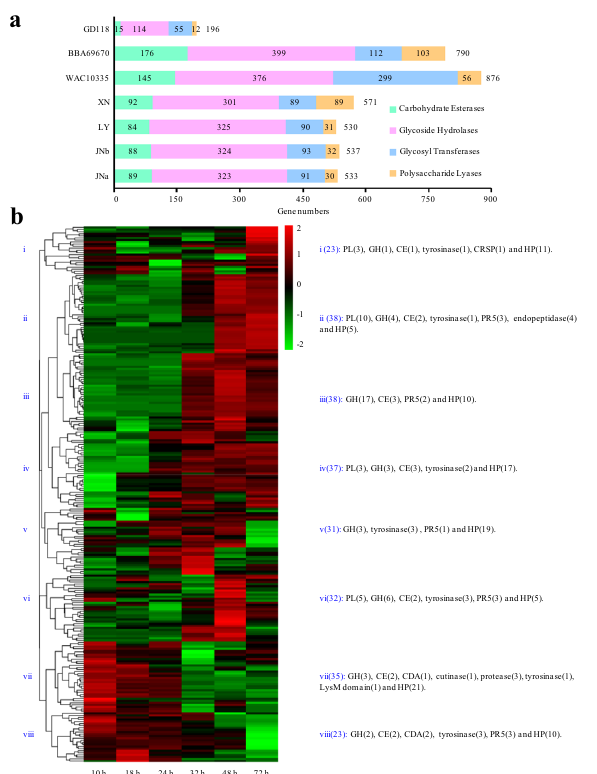
Fig. 8 Comparisons of CAZyme genes in Rhizoctonia spp. and expression of effector candidate genes in XN. a Comparison of carbohydrate-active enzyme (CAZyme) genes was conducted with BBA69670 20 , WAC10335 19 , GD118 9 , and the data sets in this study. b Expression patterns of potential effector genes of XN were analyzed using the RNA-Seq data of GD118- infected rice plants at 10, 18, 24, 32, 48, and 72 h post inoculation (BioProject, PRJNA147097). In all, 257 of 354 XN effector candidate genes were mapped by the GD118 RNA reads and used in the hierarchic analyses. The main CAZyme and some selected genes followed by gene numbers in parentheses were listed in each group. CDA chitin deacetylase,